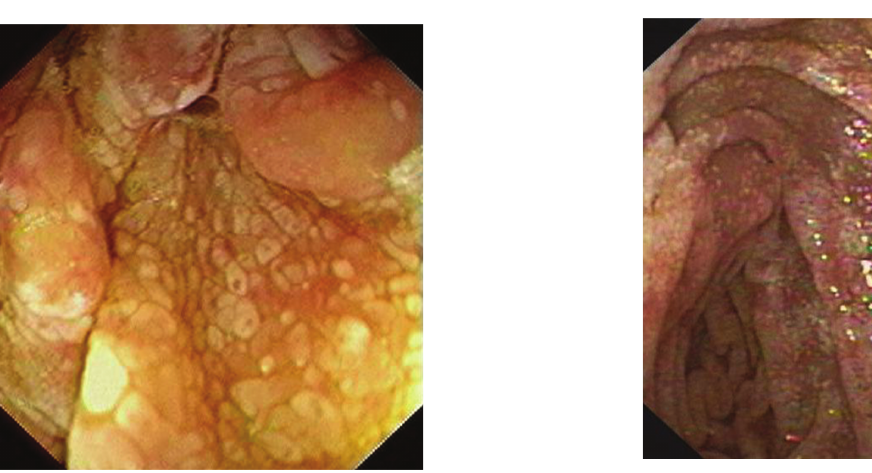
Figure 2: Whipple’s disease: jejunal mucosa is swollen and grey- pink with small whitish areas and multiple tiny mucosal haemor- rhages.